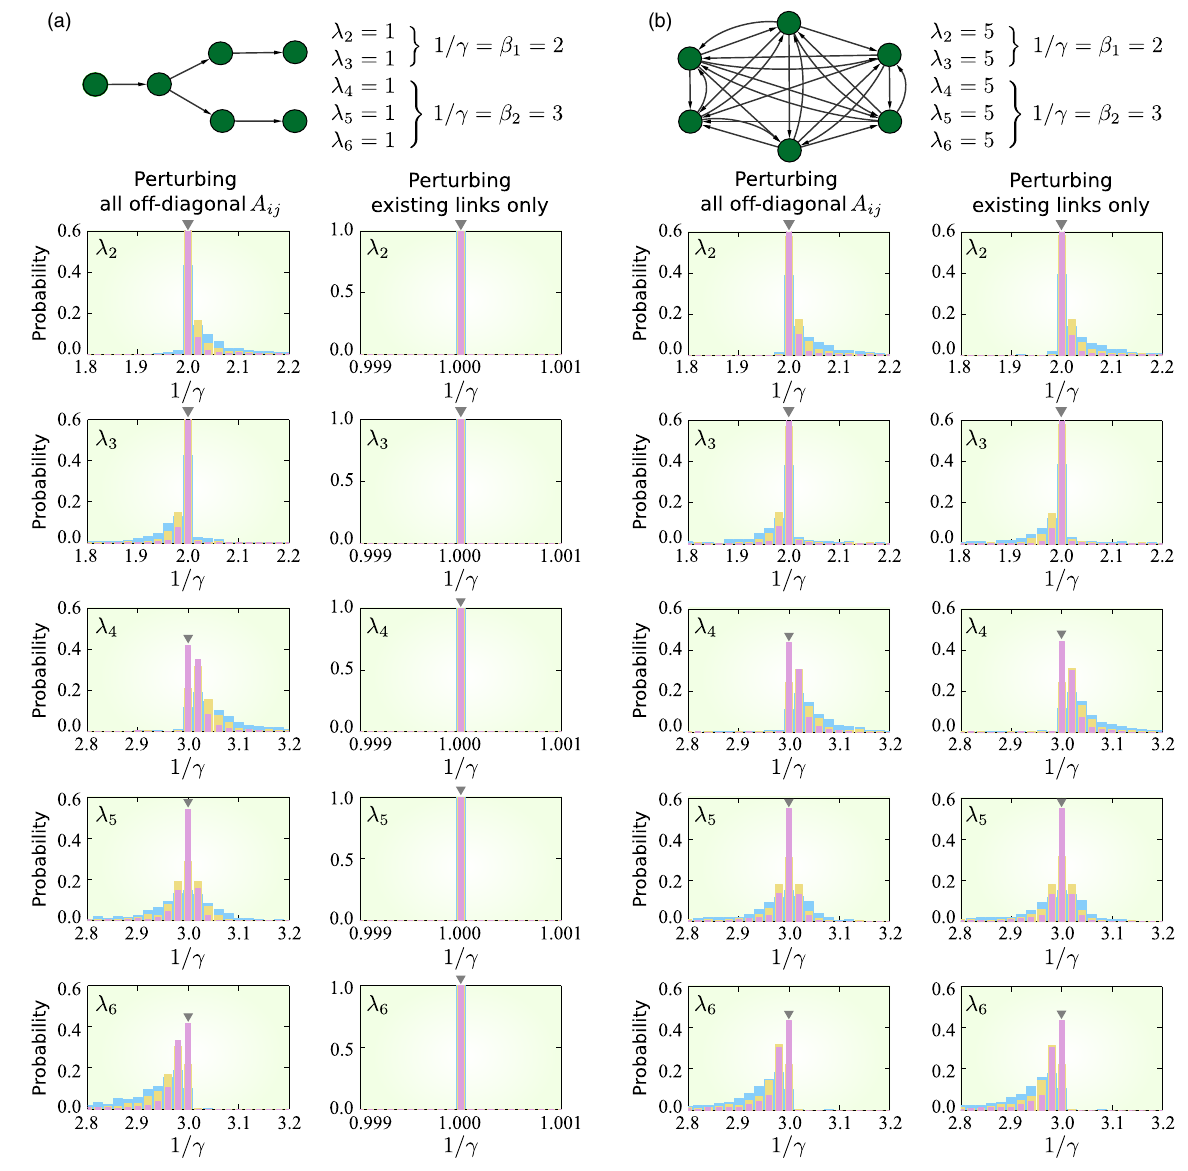
FIG. 6. Distribution of scaling exponents for the Laplacian eigenvalues of 6-node optimal directed networks under random structural perturbations. (a) Example network (a directed tree) with λ 2 ¼ (cid:2) (cid:2) (cid:2) ¼ λ 6 ¼ 1 . (b) Example network with λ 2 ¼ (cid:2) (cid:2) (cid:2) ¼ λ 6 ¼ 5 . Each plot shows histograms of 1 = γ , where γ is the scaling exponent numerically estimated from λ i (the i th smallest perturbed eigenvalue) computed at 1000 equally spaced values of δ in the intervals ½ 0 ; 10 − 3 (cid:4) (blue), ½ 0 ; 10 − 4 (cid:4) (yellow), and ½ 0 ; 10 − 5 (cid:4) (pink). We determine γ by applying MATLAB ’ s built-in linear least-squares algorithm in log scale [86]. Each histogram is generated by estimating γ for 10000 realizations of Δ A , where each element of Δ A (corresponding to the perturbation of the weight of an existing link or the addition of a new link with small weight) is chosen randomly from the uniform distribution on ½ − 1 ; 1 (cid:4) . When perturbing all the off-diagonal elements of the adjacency matrix A (plots on the left-hand side of each panel), the results support 1 = γ ¼ β j for both networks. When perturbing only the existing links (plots on the right-hand side of each panel), the scaling exponent depends on the initial network: the plots support 1 = γ ¼ 1 for the directed tree in (a) and 1 = γ ¼ β j for the network in